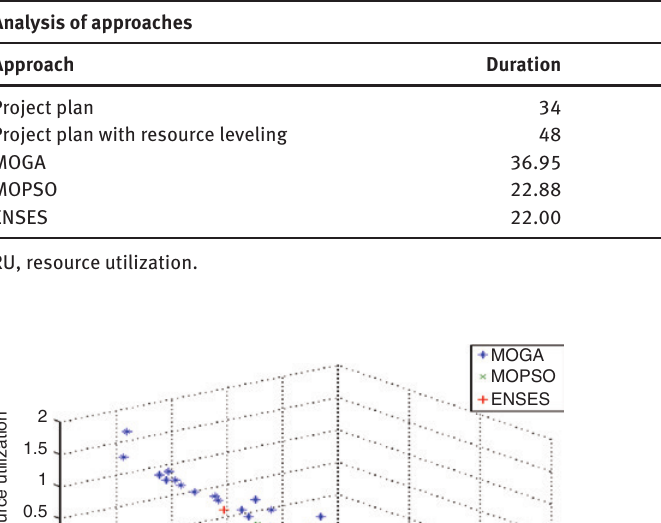
Table 3: Analysis of Approaches.